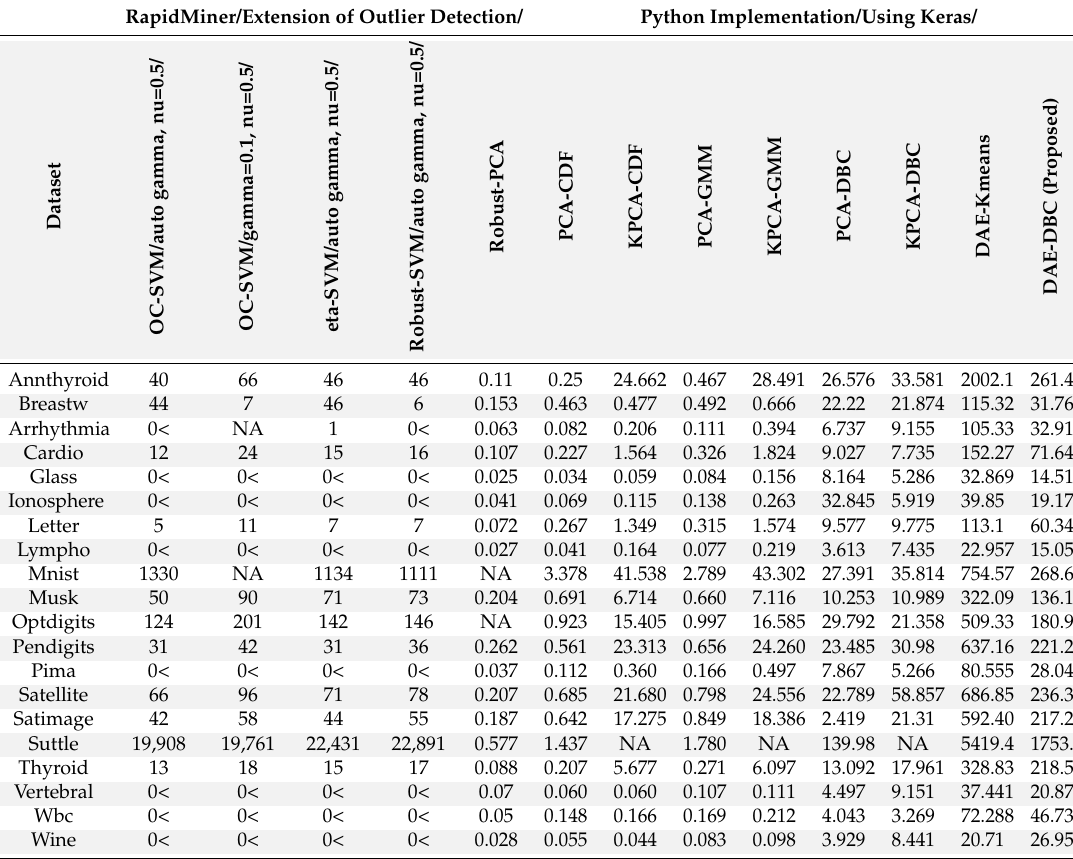
Table 4. Comparison of computation time of